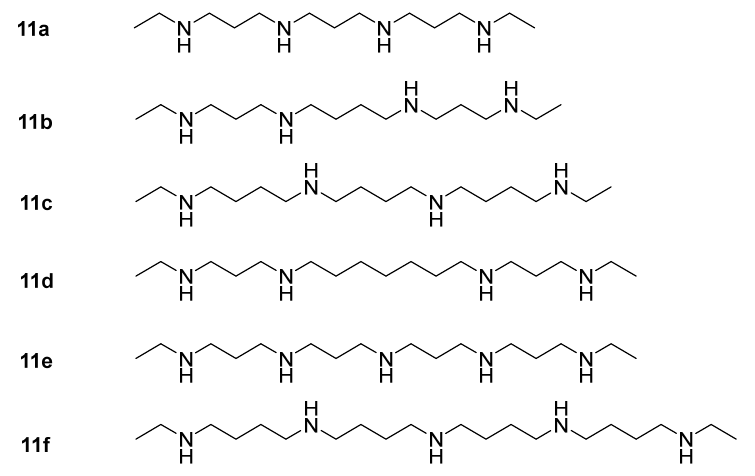
Figure 11. Chemical structures of polyamine analogs 11a – 11f [73].